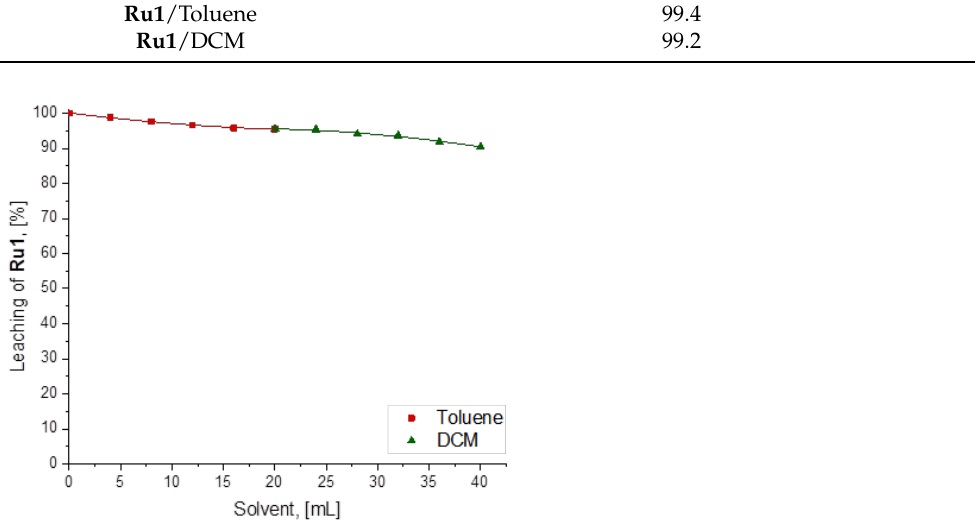
Table 1. Results of absorption experiments of Ru1 from toluene and DCM. Catalyst/Solvent